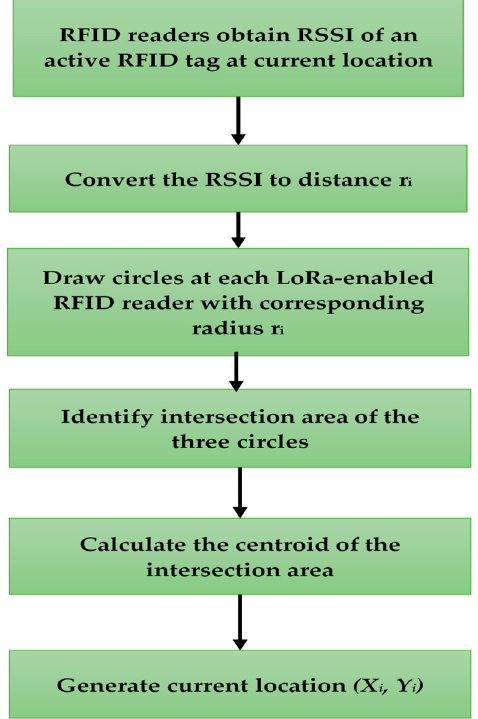
Figure 2. Flowchart illustrating the process of location identification using triangulation technique.